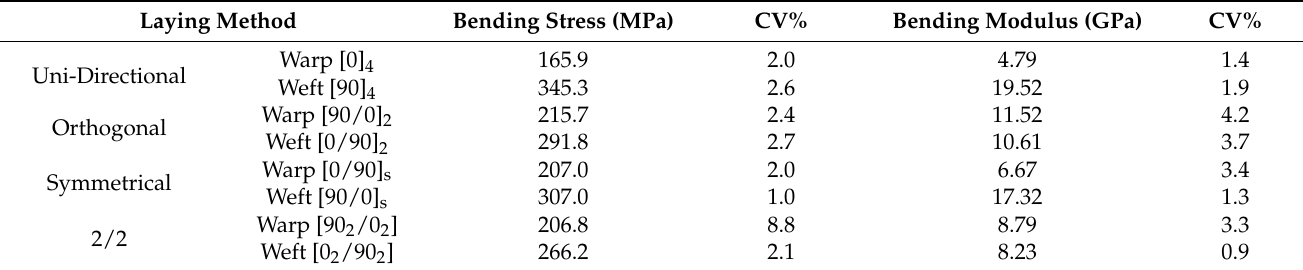
Table 6. The bending properties of materials with different laying methods.